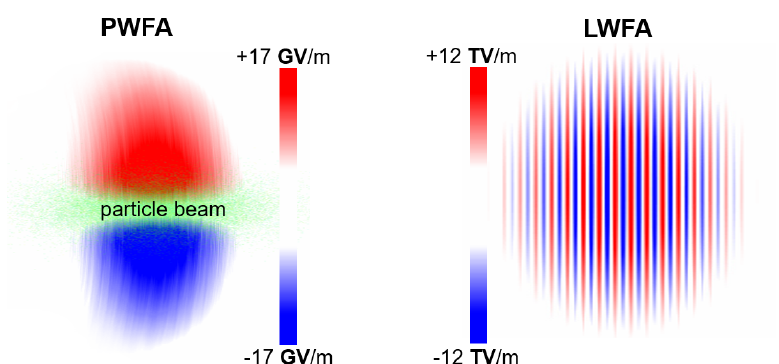
Figure 4. The electric fields of electron bunch PWFA drivers are unipolar, while electric fields of laser pulse LWFA drivers are oscillating. As a result, the peak electric fields, which are required to excite a similarly strong blowout/bubble, are three orders of magnitude lower for PWFA than for typical LWFA Ti:sapphire